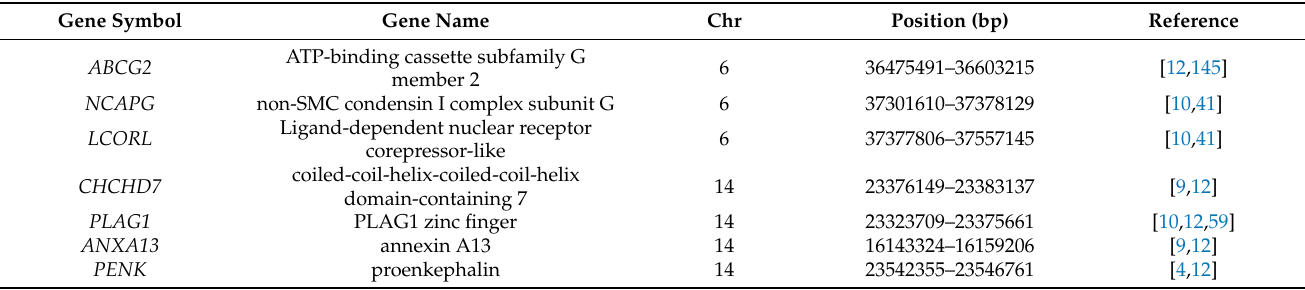
Table 4. Description and chromosomal location of the most important genes related to yearling weight in Hanwoo